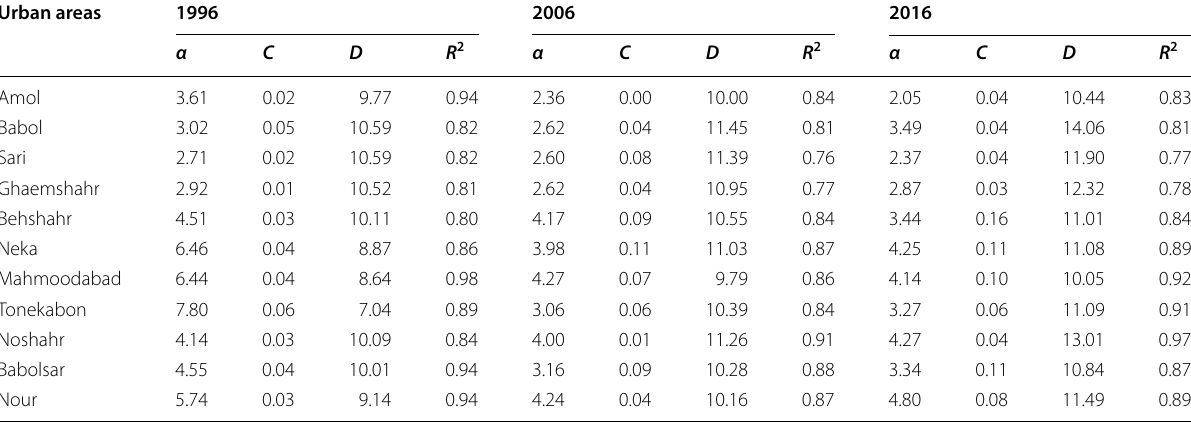
Table 6 Fitted parameters of the selected urban areas Urban